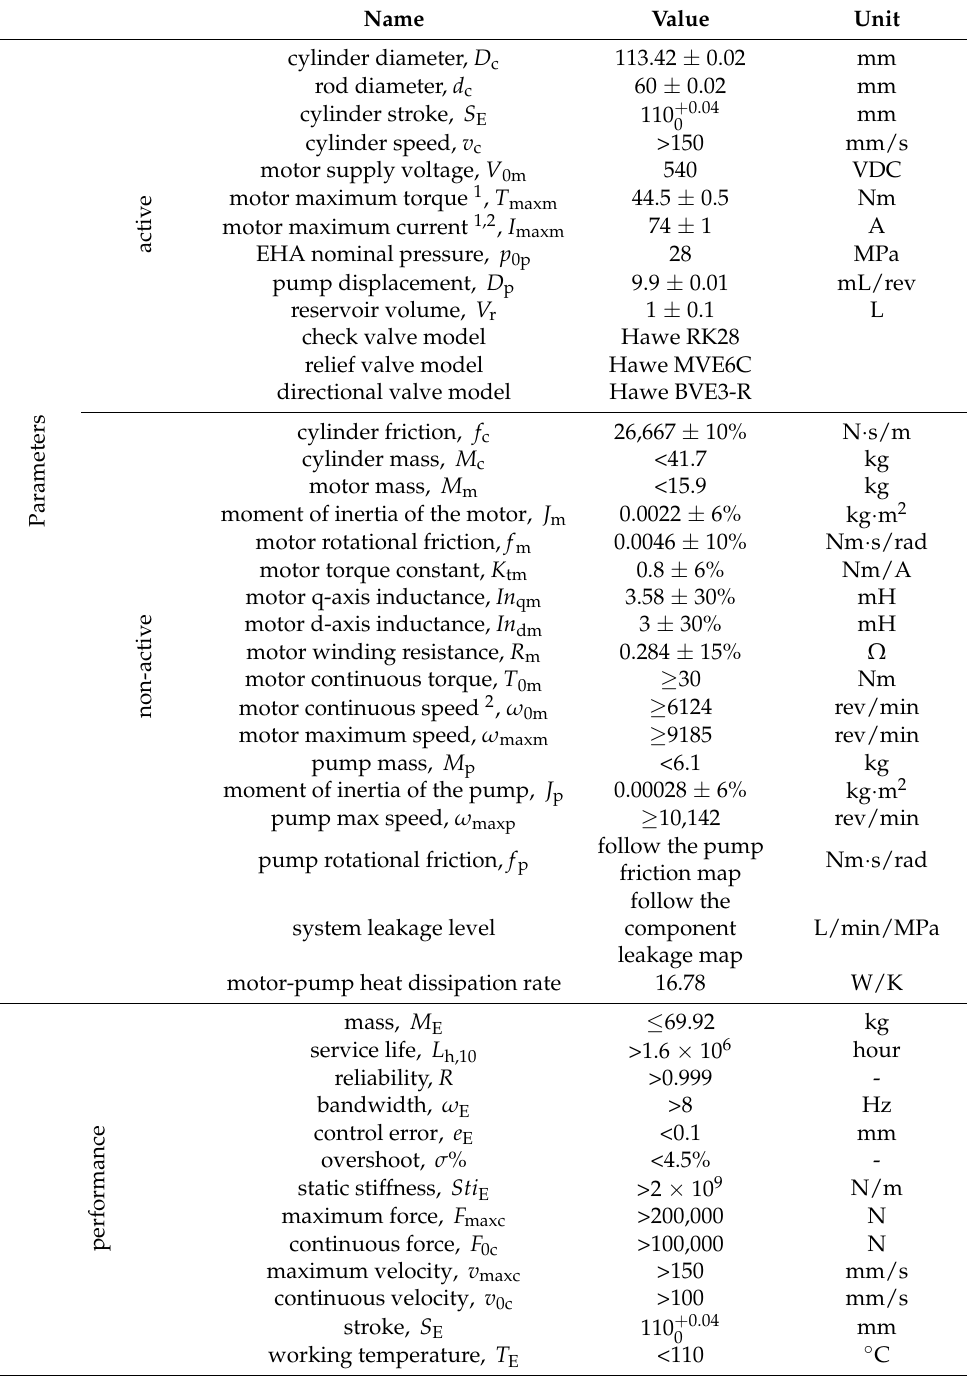
Table 6. The preliminary design results of the 30 kW